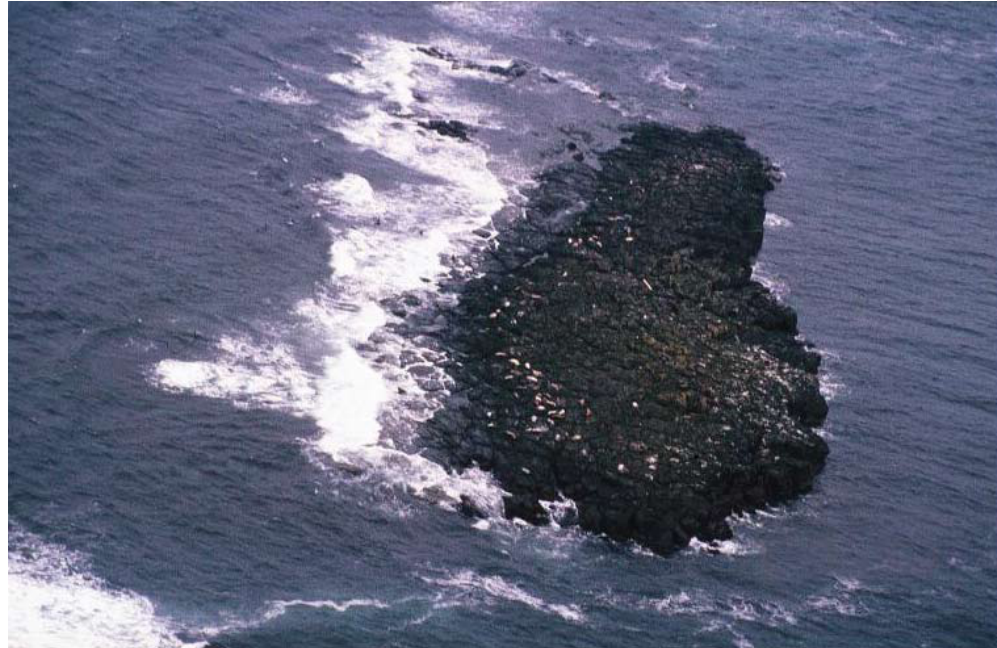
Fig. 1. Typical grey seal breeding habitat: a rocky island off Iceland. (Photo: